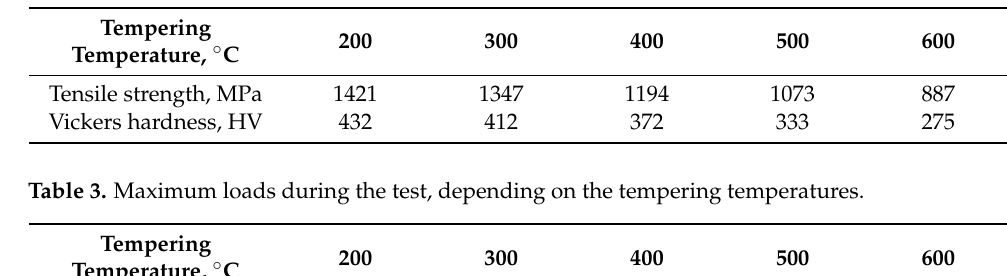
Table 2. Average mechanical properties of tested steel from seven heats depending on the temper- ing temperature.